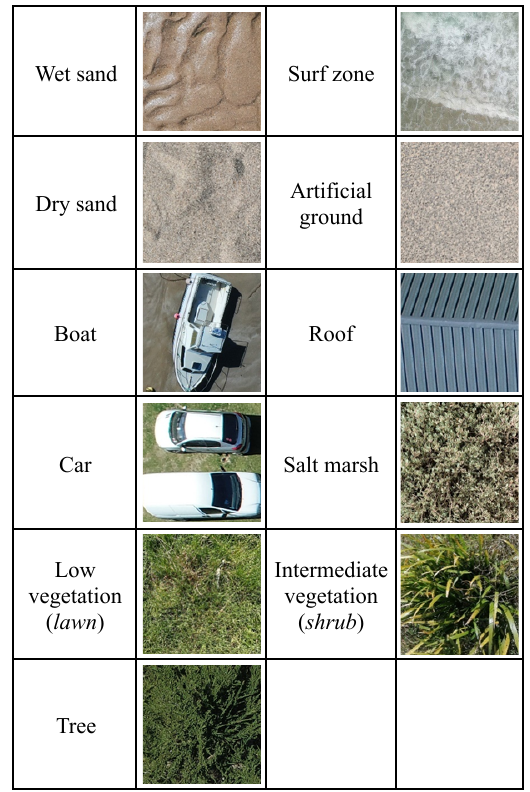
Table 1. Presentation of the land and sea covers classes studied.